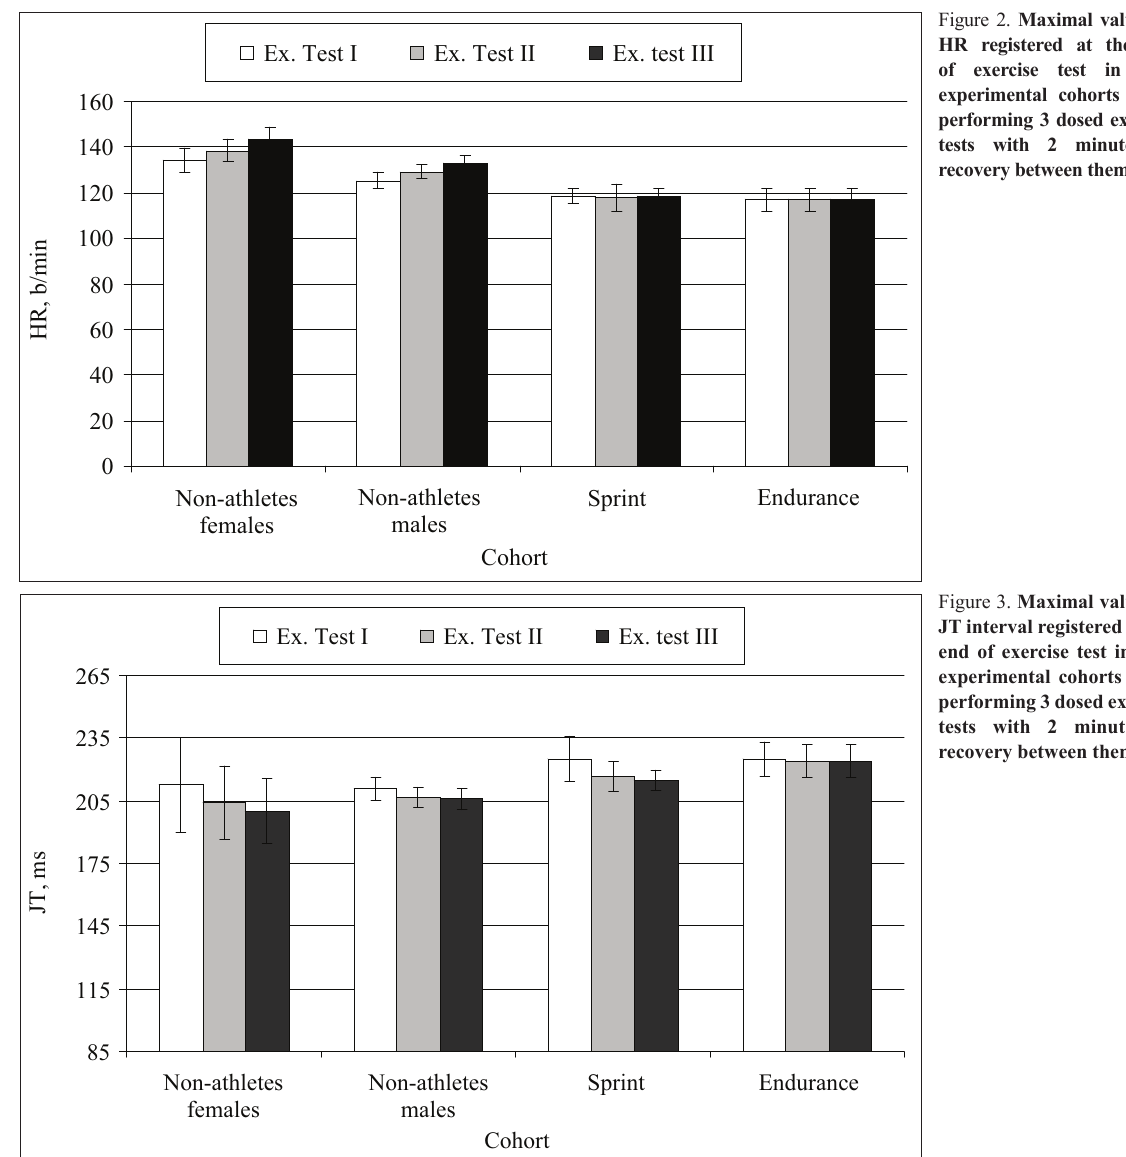
Figure 2. Maximal values of HR registered at the end of exercise test in four experimental cohorts while performing 3 dosed exercise tests with 2 minutes of recovery between them